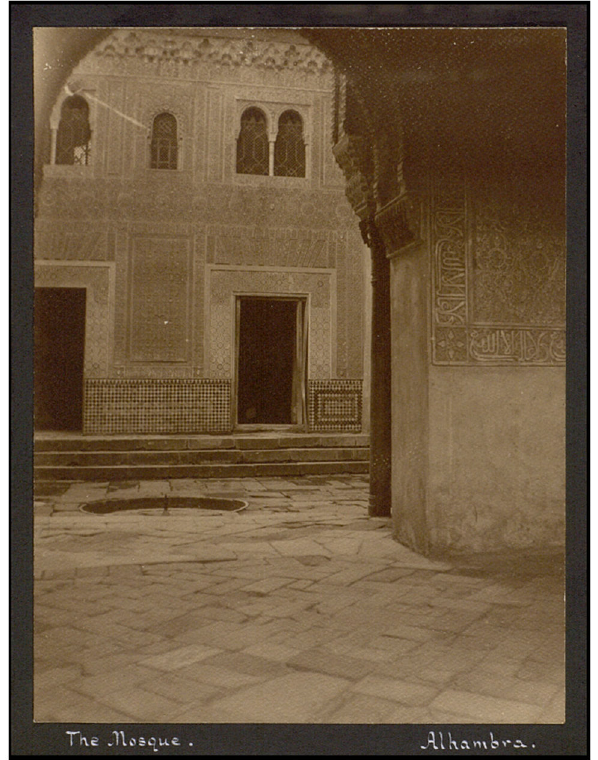
Figure 28. Ceramic dado on the facade of the Comares Palace featuring a similar design to those in the Cuarto Dorado. Missing ceramic dado from the south wall of the same hall. Photograph by Harold Dempster (c. 1900). © Archivo del Patronato de la Alhambra y Generalife, Photograph Collection,